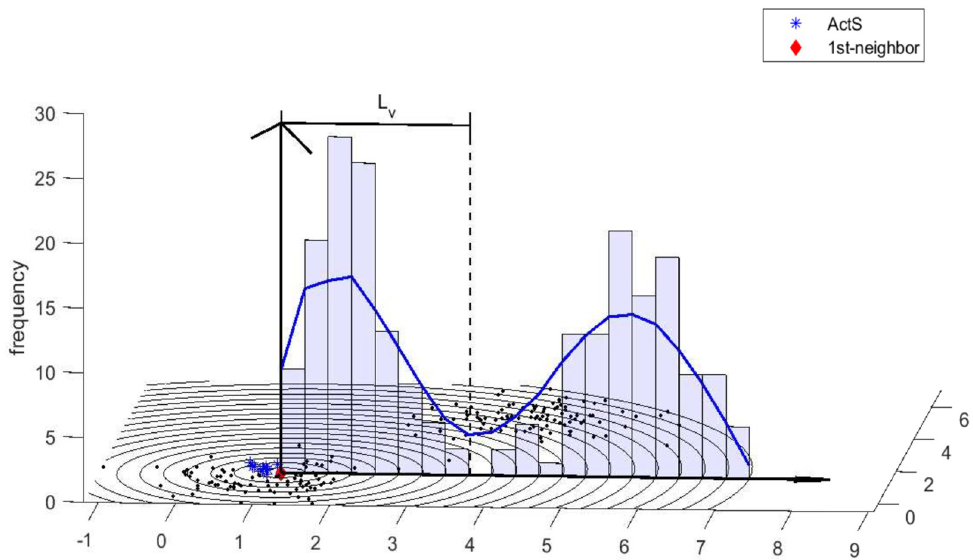
Fig 2. Presentation of active set and its 1st-neighbor. The distribution of distances between 1st-neighbor and all data items is presented; the histogram shows the frequency of distances; the corresponding blue line is smoothed frequency, acting as a approximated curve of probability density function